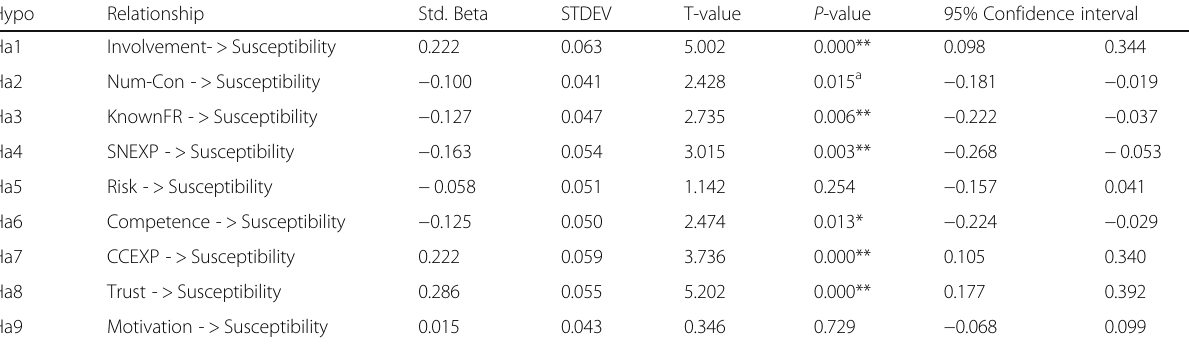
Table 4 Path coefficient results (significance testing- group a) Hypo